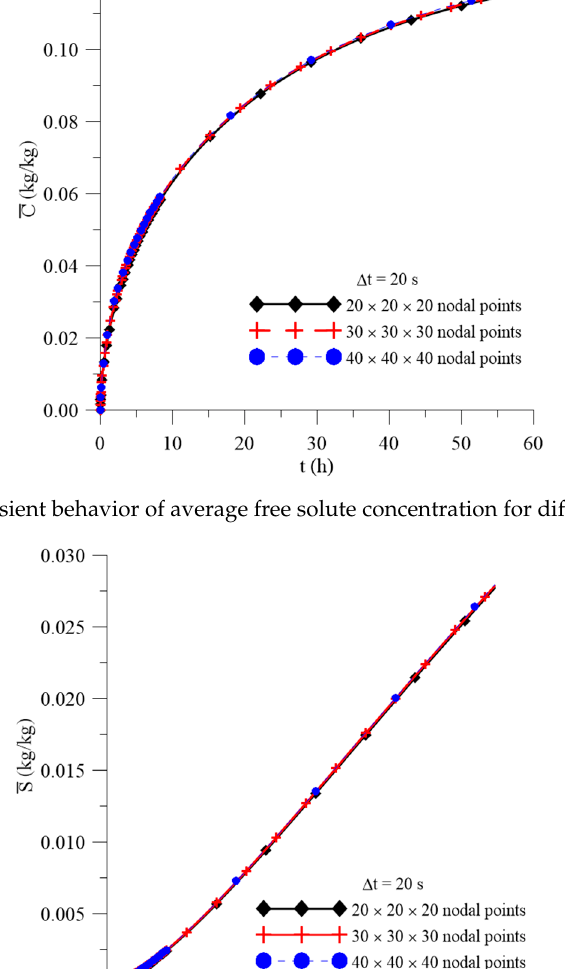
Table 3. Parameters used in the simulation for the three-dimensional (3D) case. Case Table 4. Parameters used in the simulation of arbitrary cases. Case